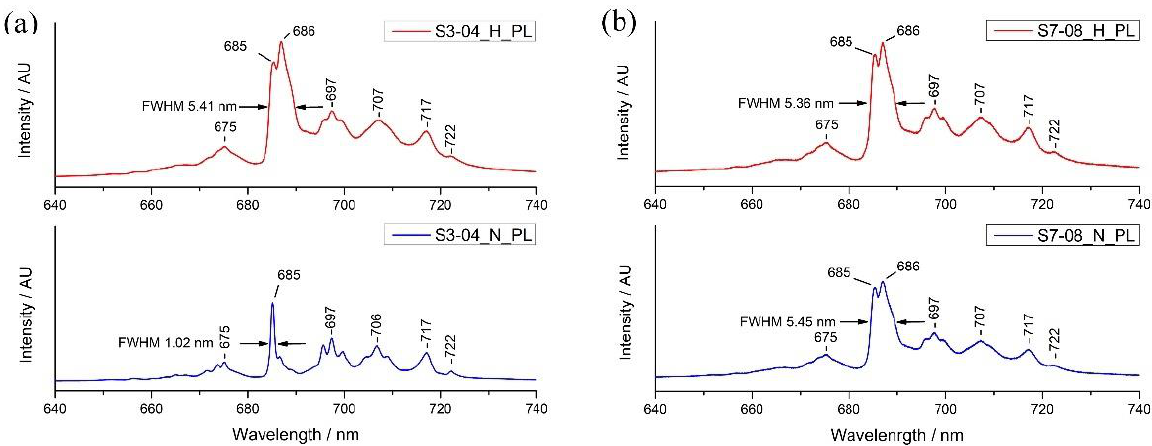
Figure 4. Representative PL spectra of ( a ) orange spinel as a representative pattern of most samples, and ( b ) green spinel with dissimilar pattern to the other spinels both before (blue lines, lower spectra) and after heating experiment (red lines, upper spectra).